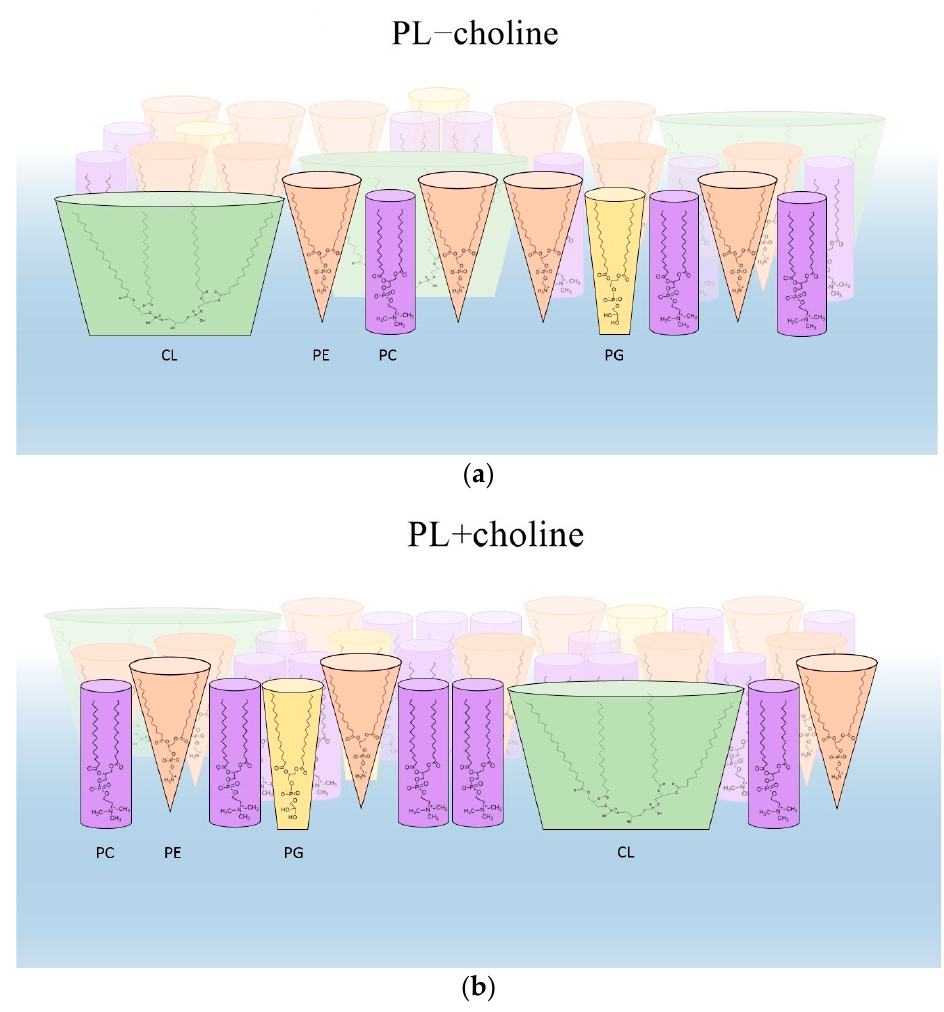
Figure 6. The effect of molecule shape on packing of the mixed monolayers, composed of phospho- lipids isolated from L. gormanii bacteria cultured without ( a ) and with ( b ) choline.